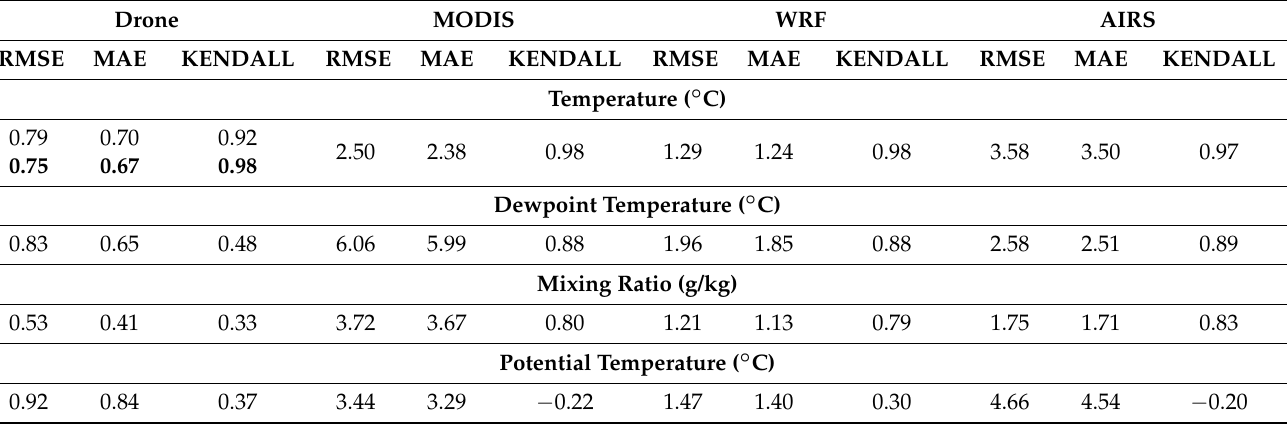
Table 3. Average values of the statistical metrics of drone, MODIS, and WRF profiles for the four variables analyzed up to 300